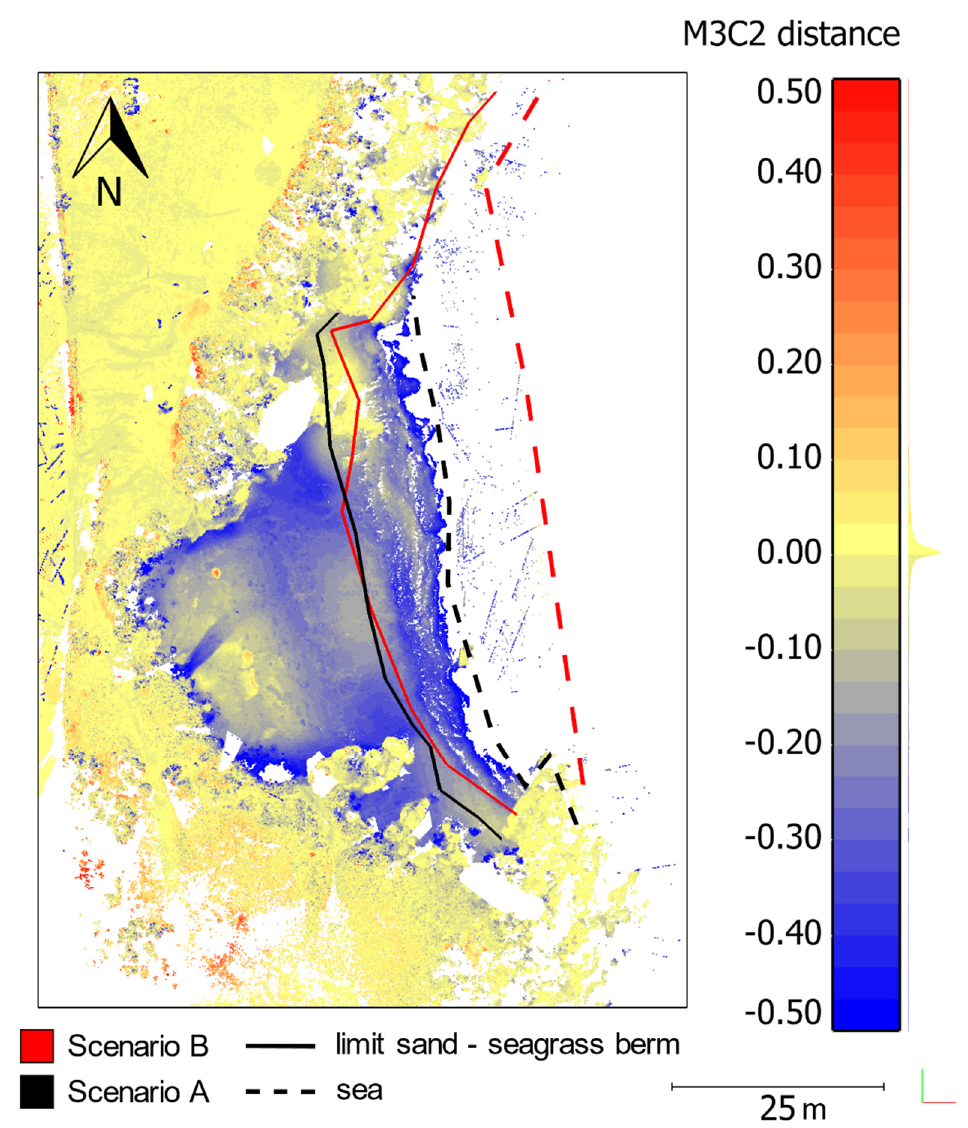
Figure 6. Height variation between scenario/sampling date A: 24 November 2016, and scenario/sampling date B: 22 March 2017. Distances were calculated through the comparison of the respective 3DPC using the Multiscale Model to Model Cloud Comparison (M3C2) in the vertical direction [45]. Negative values show erosion from scenario A to scenario B, while positive values show accretion.